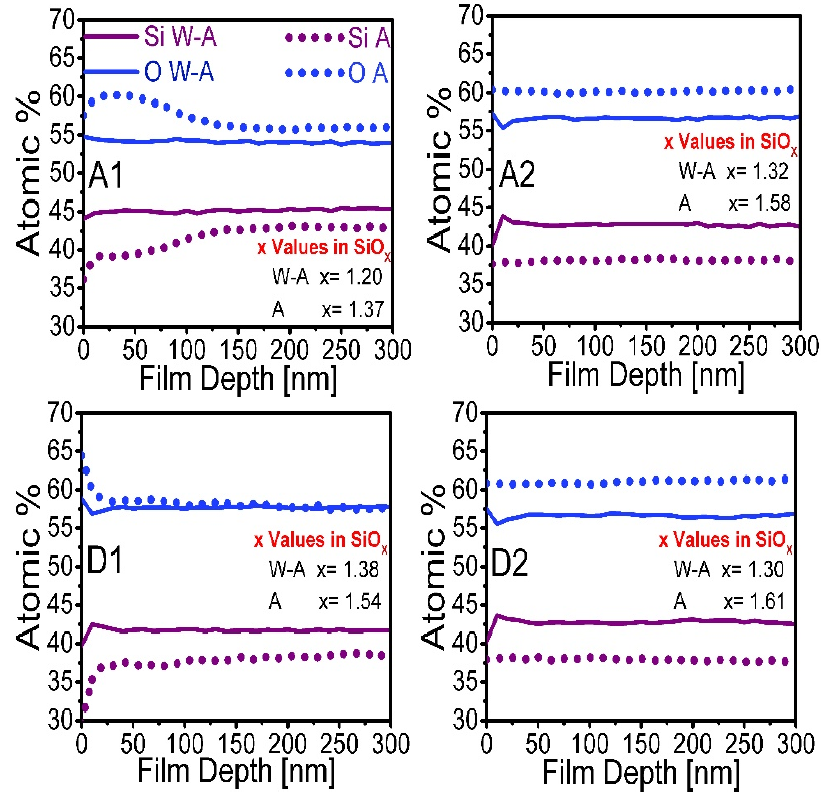
Figure 6. Compositional profile of silicon and oxygen obtained using XPS according to the depth of penetration in the SiO x film and x values in the SiO x stoichiometric ratio.